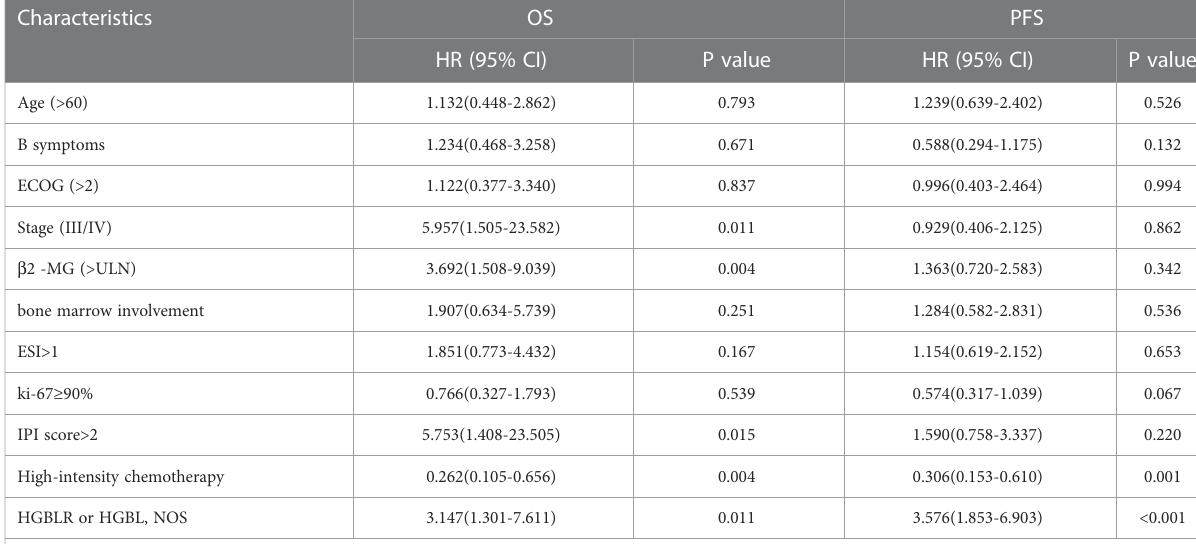
TABLE 5 Multivariate analysis of risk factors associated with OS and PFS.